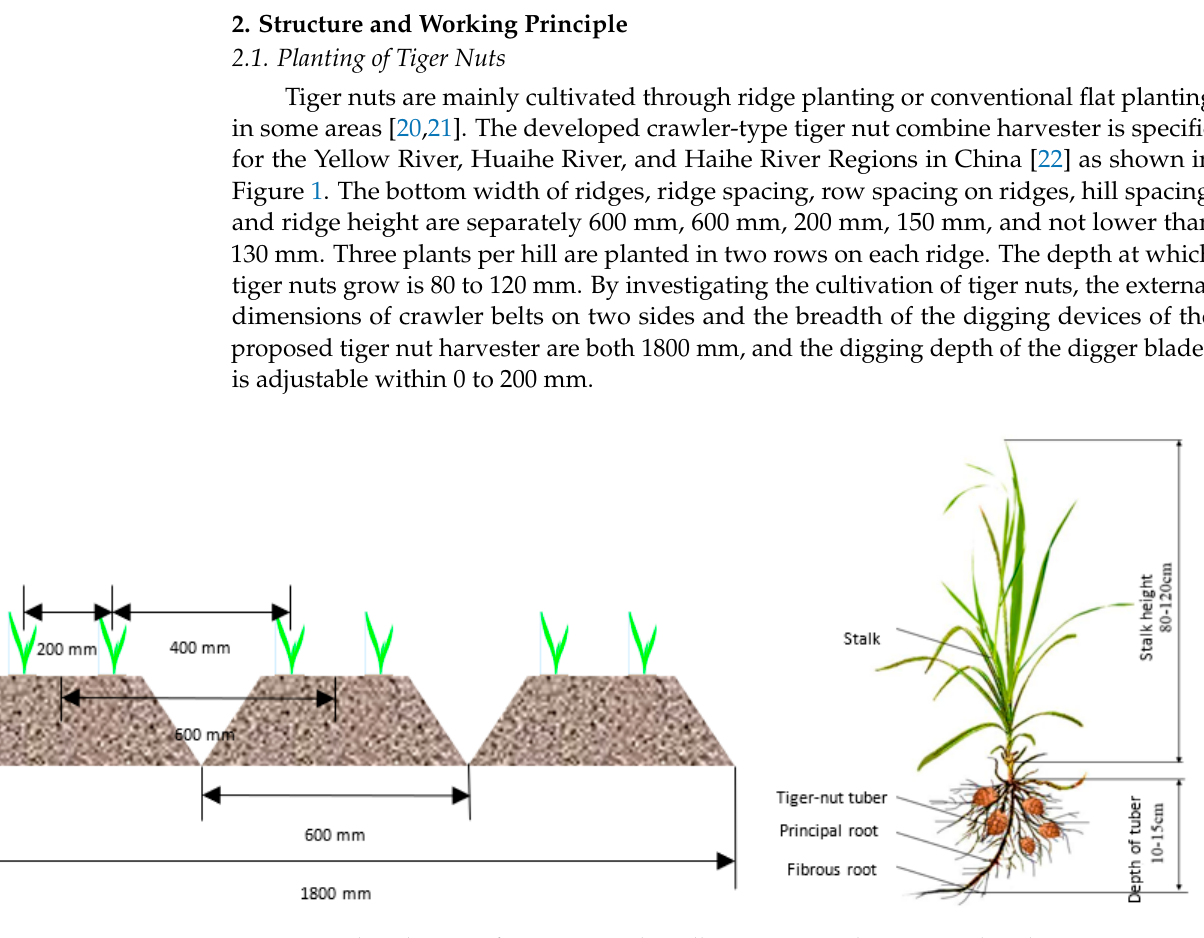
Figure 1. Ridge planting of tiger nuts in the Yellow River, Huaihe River, and Haihe River Regions. The average triaxial dimensions ( L , W , T ) of 100 undamaged and pest-free tiger nuts were measured with 111N-101 digital display vernier caliper (resolution 0.01 mm). The sizes measured of tiger-nut tubers are illustrated in Figure 2. The results of the triaxial dimensions statistical analysis of tiger nuts are shown in Table 1.